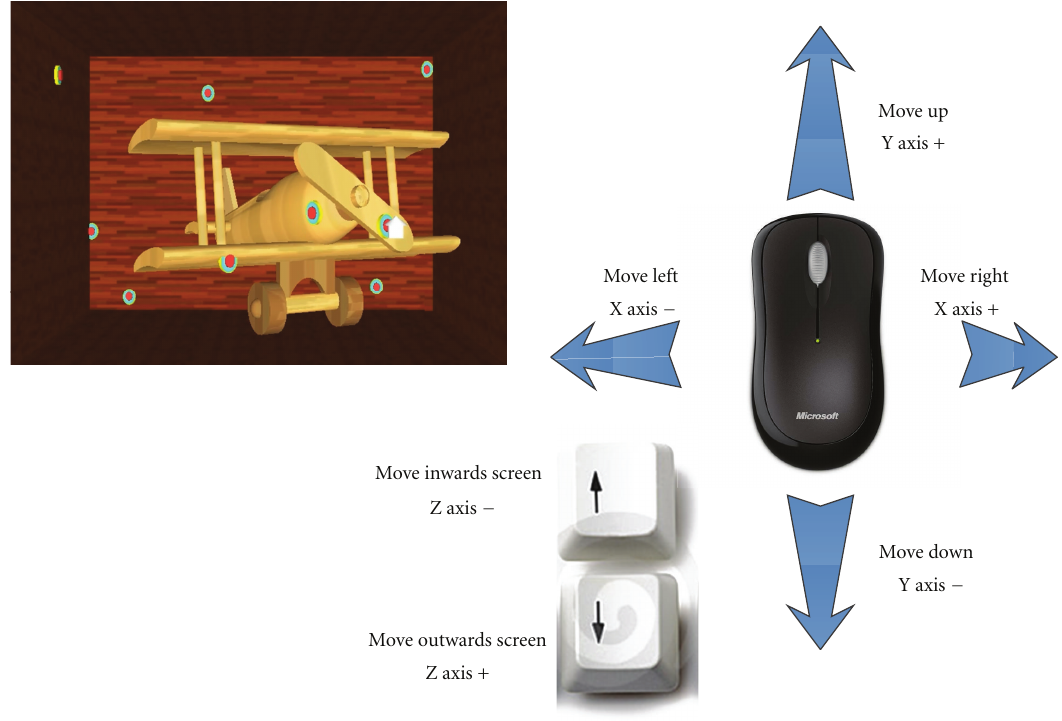
Figure 5: Volume-based selection techniques using mouse and keyboard with